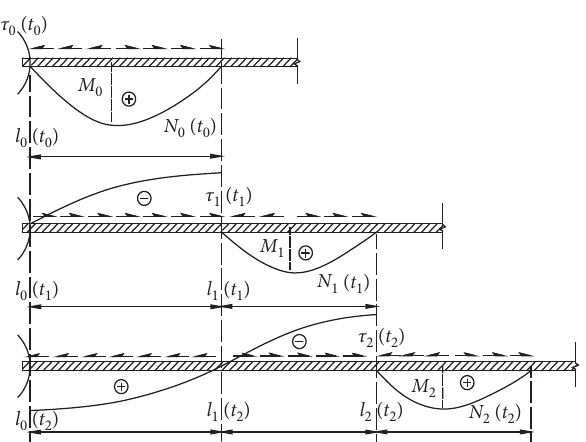
Figure 4: Bolt stress distribution at different times after supporting the